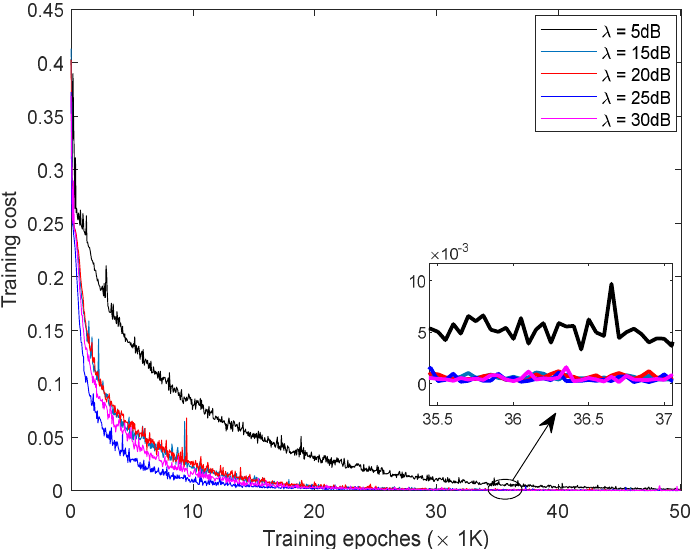
Figure 5. The cost performance comparison for different training SNRs under the NLOS case.